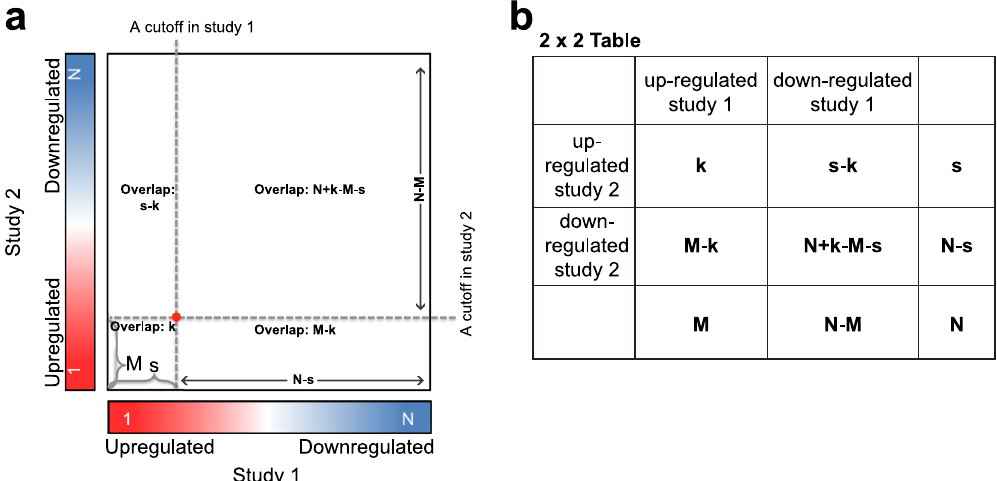
Figure 1. Representation of RRHO. ( a ) For study 1 on the x-axis, all genes are ranked based on their p -values and effect size direction; the most significantly up-regulated genes are the farthest to the left on the x-axis (red), the most significantly down-regulated genes are the farthest to the right on the x-axis (blue), and the relatively unchanged genes are in the middle of the x-axis (white). Similarly, the genes in study 2 are ranked from most significantly up-regulated (bottom, red), most significantly down-regulated (top, blue), unchanged (middle, white) in between. ( b ) A 2 × 2 contingency table. Using the table, calculation of the hypergeometric p -value can be computed